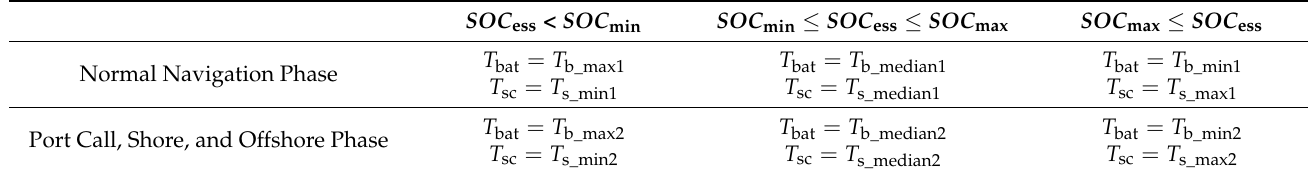
Table 2. Table of rules for variable filter time